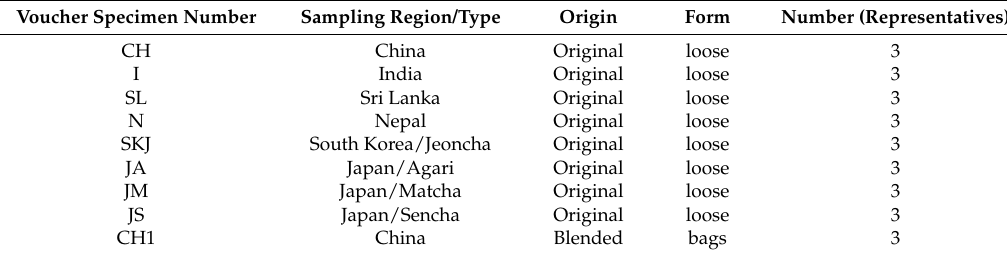
Table 1. Characteristic of the investigated green